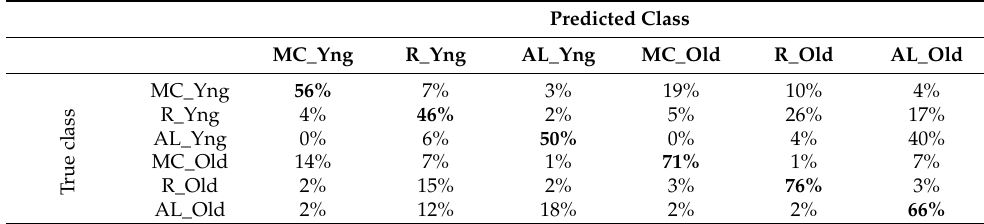
Table 3. Confusion matrix of SVM-Linear for the multi-class recognition task. Six classes are considered, one for each couple of the cognitive load task: math calculation MC, reading R and audio listening AL, and subject age: young adult (Yng), and older adults (Old). The values in bold are the main diagonal elements and represent the cases where the classes predicted by the classifier and true classes